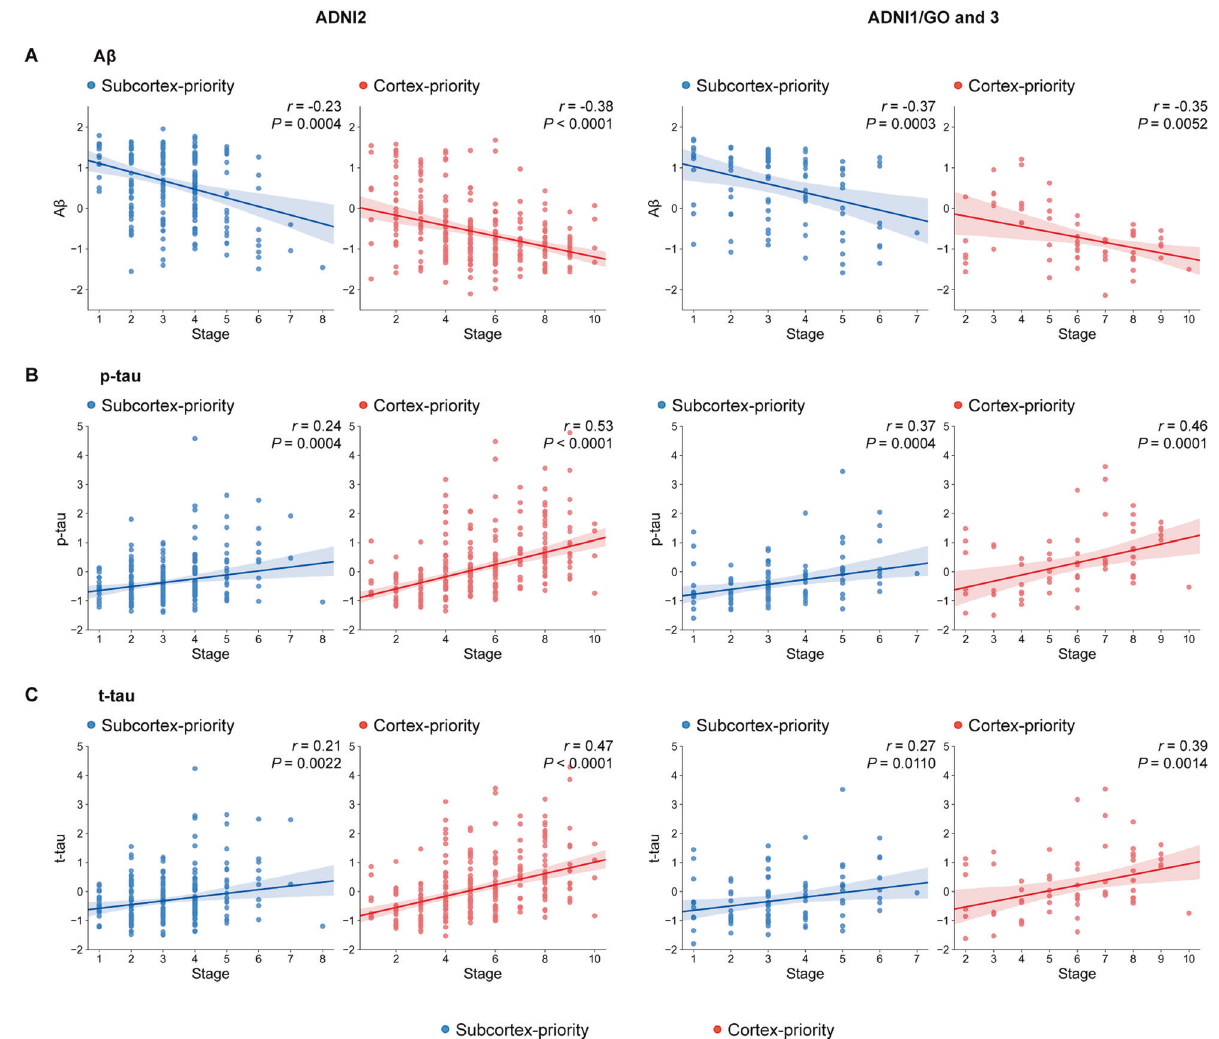
Fig. 3 Biomarkers pro fi les are correlated with progression patterns of amyloid in each subtype. A Higher progression stages of the subcortex-priority and cortex-priority subtypes were associated with lower CSF A β across the discovery and validation datasets. B Higher stages of each subtype were associated with increased levels of CSF p-tau across the two datasets. C Similarly, the signi fi cant associations between stages of each subtype and CSF t-tau. All associations were tested by Spearman correlation while controlling covariates (age, gender and education).